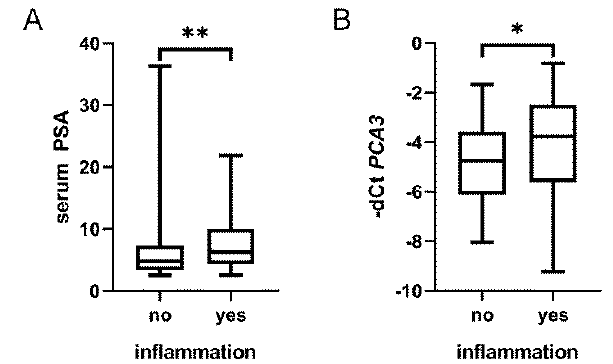
Figure 2. Inflammation in BPH tissue affects serum PSA and urine PCA3 . Serum PSA levels ( A ) and to a lesser extent also urine PCA3 ( B ) were significantly higher in patients with inflamed BPH tissue ( p values 0.005 and 0.040, respectively). Box-plots represent median, 25 – 75% percentiles and range of values. p -values < 0.05 and < 0.01 are indicated by * and **, respectively.